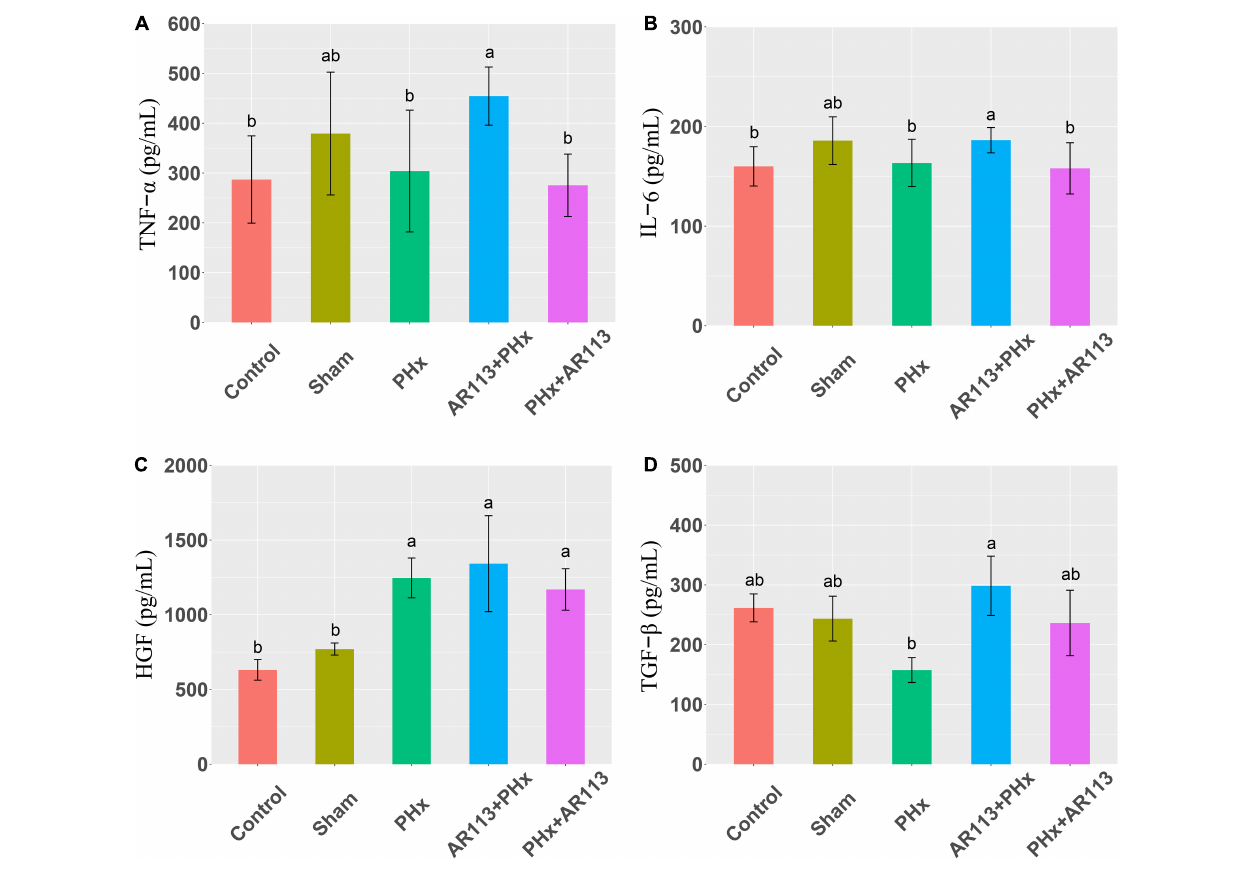
FIGURE 3 | Cytokines and growth factors at 7 days after PHx among the Control, Sham, PHx, AR113+PHx, and PHx+AR113 groups. (A) Changes in TNF- α levels; (B) Changes in IL-6 levels; (C) Changes in HGF levels; (D) Changes in HGF- β levels. Different letters indicate significant differences, P < 0.05 (ANOVA followed by Tukey’s HSD